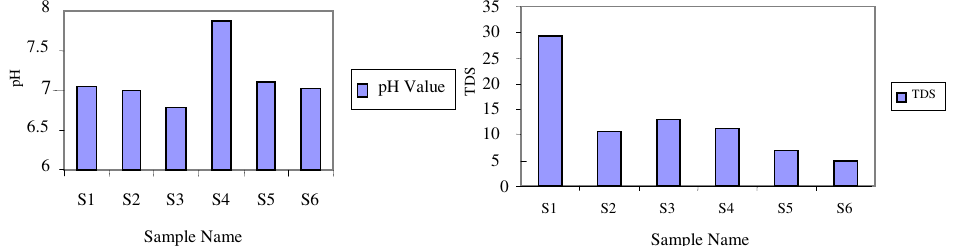
Figure 3. pH value of various sample Figure 4 . TDS value of various